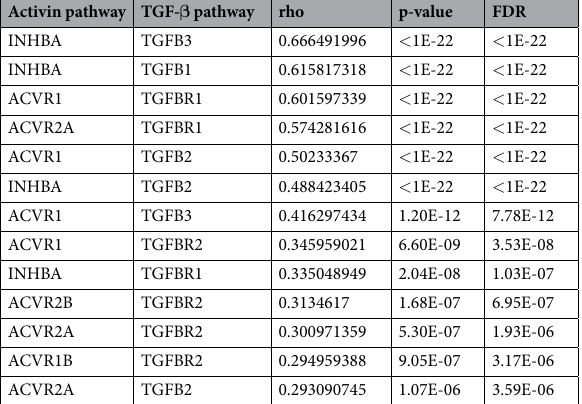
Activin pathway TGF- β pathway rho p-value FDR